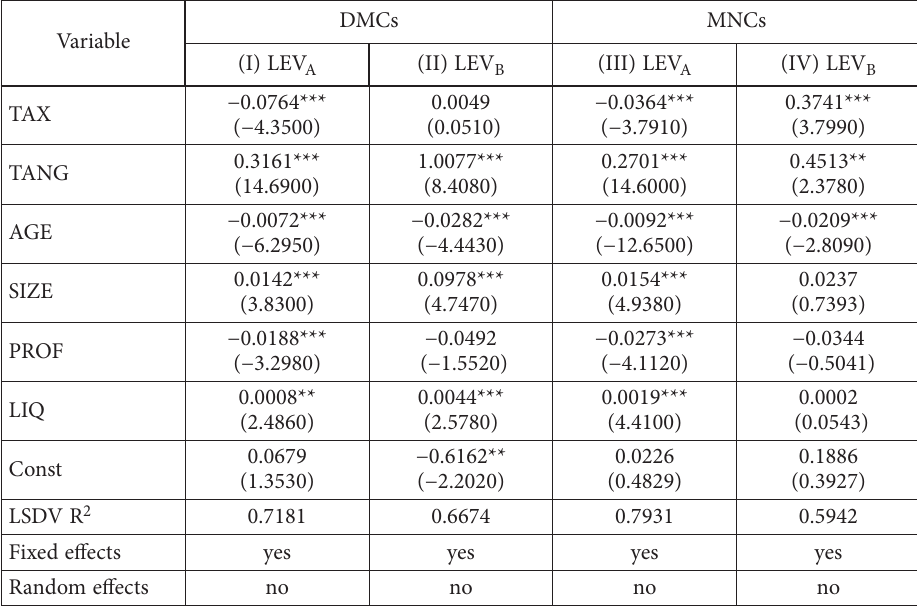
Table 6. Regression results: Czech